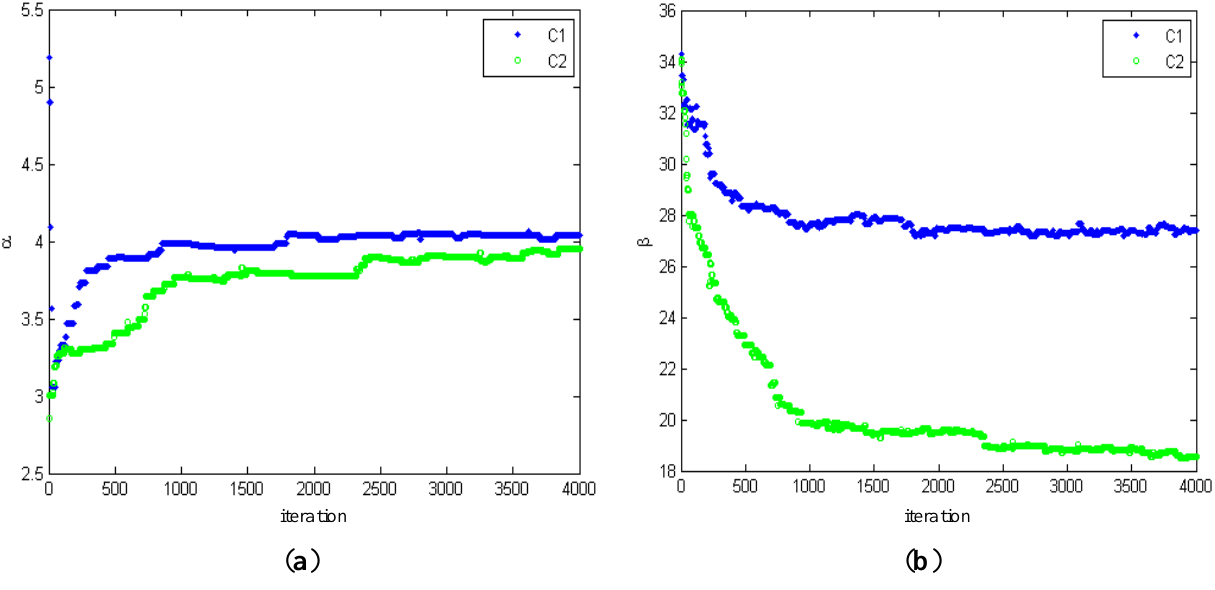
Figure 3. Changes of ( a ) estimated shape parameters and ( b ) scale parameters during 4,000 iterations.